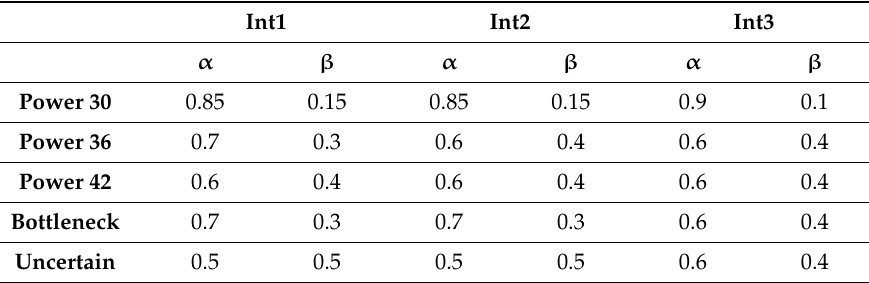
Table 2. Best values of α and β for the simulation